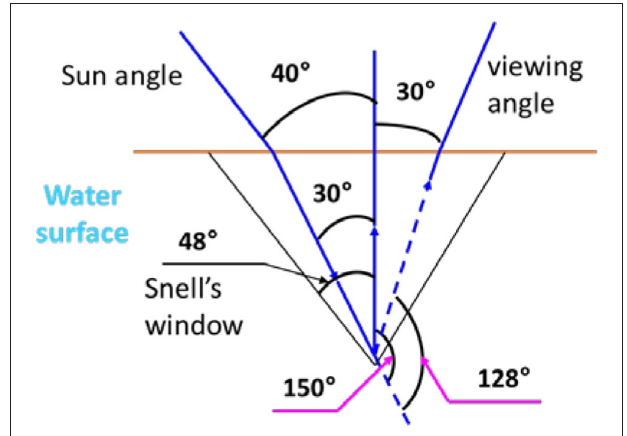
FIGURE 8 | Air-sea interface showing the refraction of the light from below to above the ocean. The solid black lines show the limits of the Snell